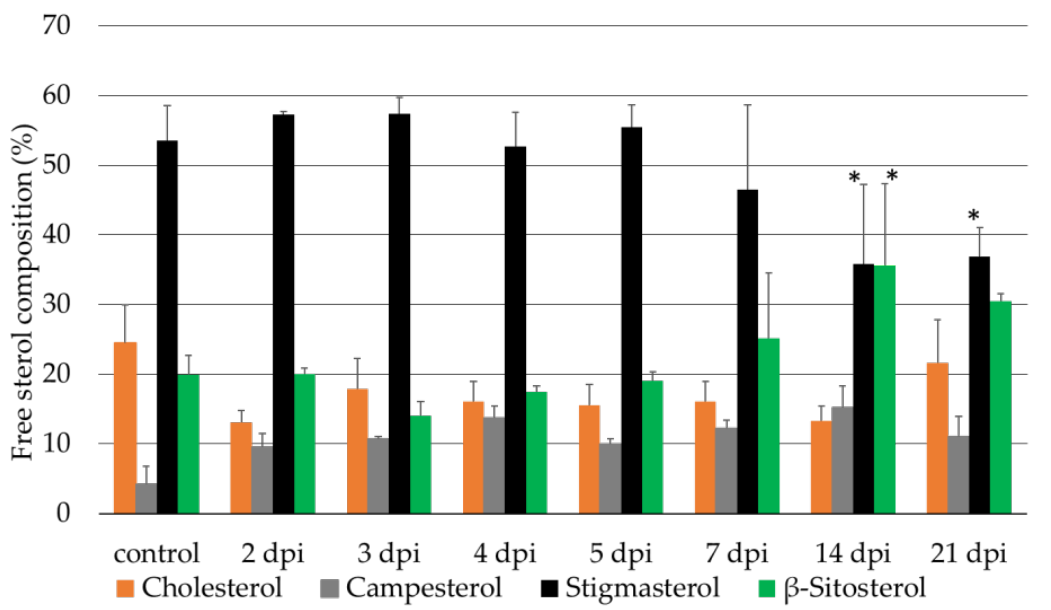
Figure 4. Chemical characterization of the wt tomato cv. Micro-Tom free sterol composition for the uninfected (control) plants and 2, 3, 4, 5, 7, 14 and 21 days post-inoculation with M. incognita (dpi) using gas chromatography–mass spectrometry. n = 4 biological replicates of 2 pooled plants per analysis. ANOVA was used for comparisons of the time and sterol alterations. *, significantly different from the control at p < 0.05. Table 2. Gas chromatography–mass spectrometry analysis of the free sterol compositions of the roots and leaves from the tomato cv. Micro-Tom wt and cyp710a11 mutant infected with M. incognita . Samples were taken at 28